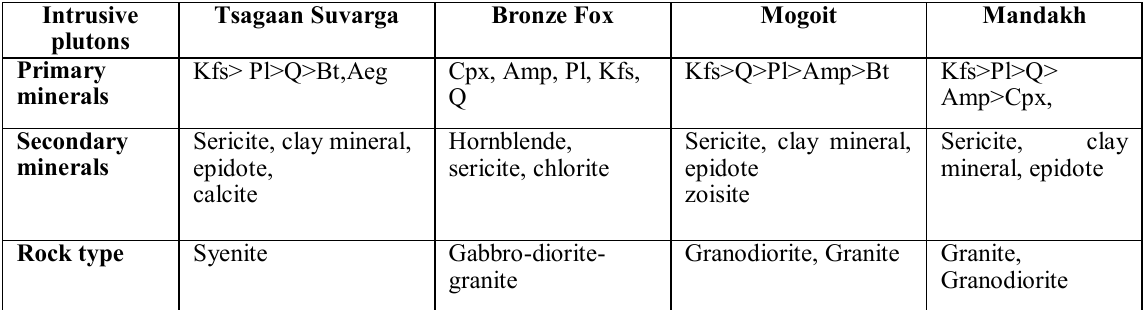
Table 2. Petrographical features of the intrusions in Mandakh